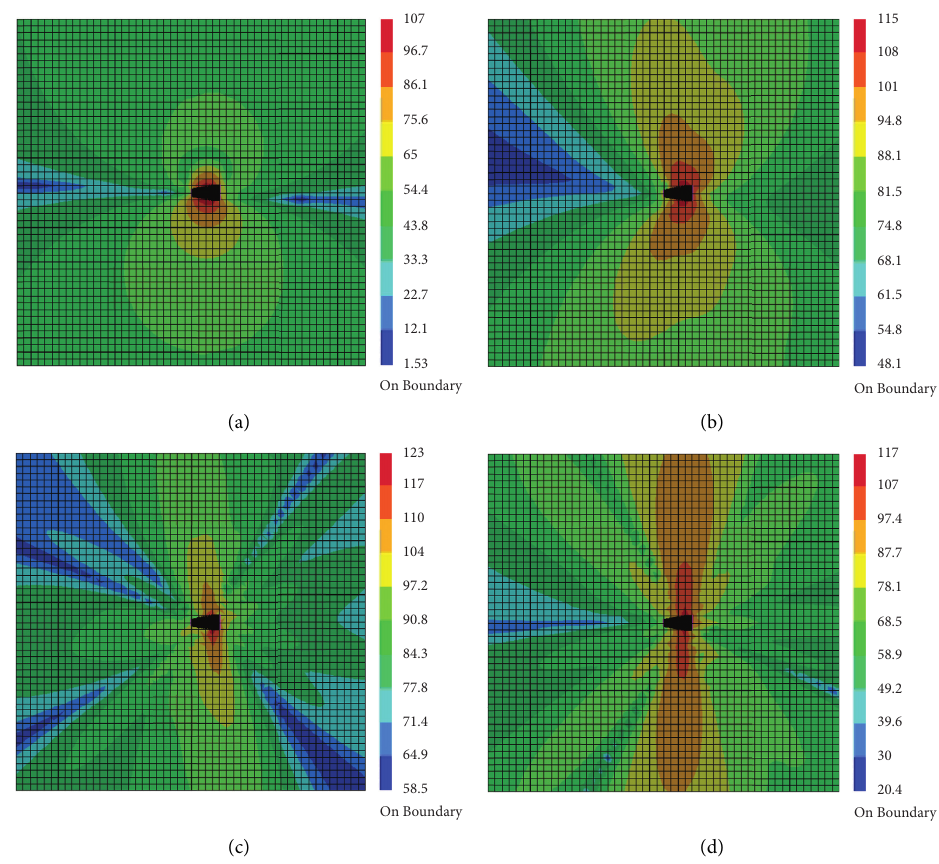
Figure 6: Acoustic radiation field at different frequencies in the yoz plane. (a) 50Hz. (b) 1000Hz. (c) 2000Hz. (d)